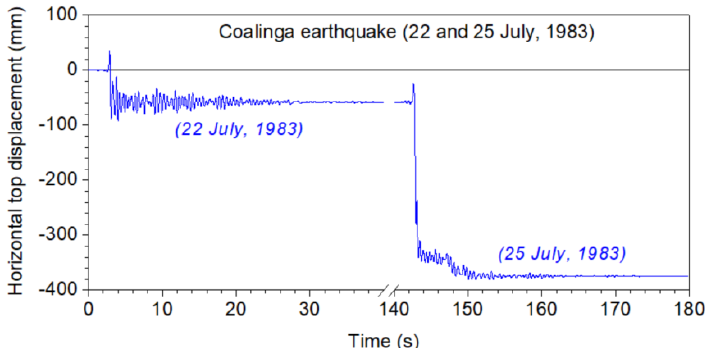
Figure 12. Fixed-base platform under the Coalinga earthquake (22 and 25 July 1983): time history of horizontal top displacement.